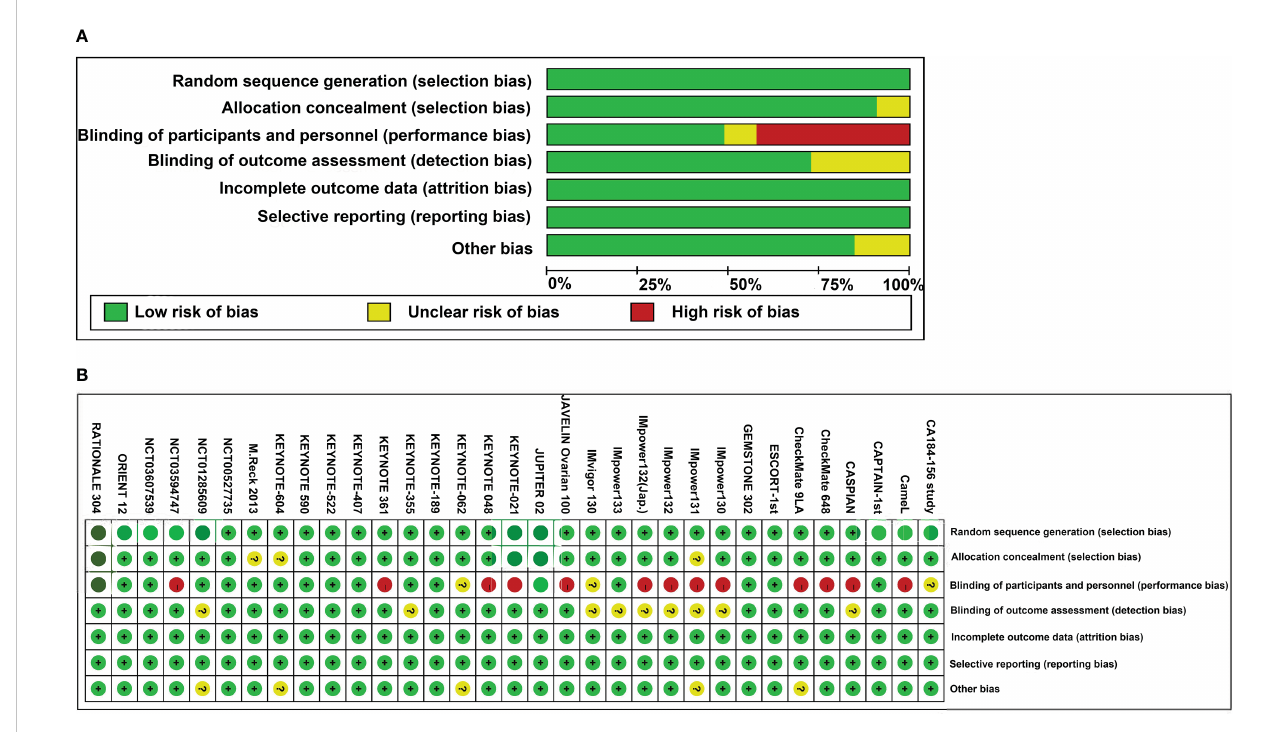
FIGURE 3 Risk bias assessment (A) Risk of bias graph; (B) Risk of bias